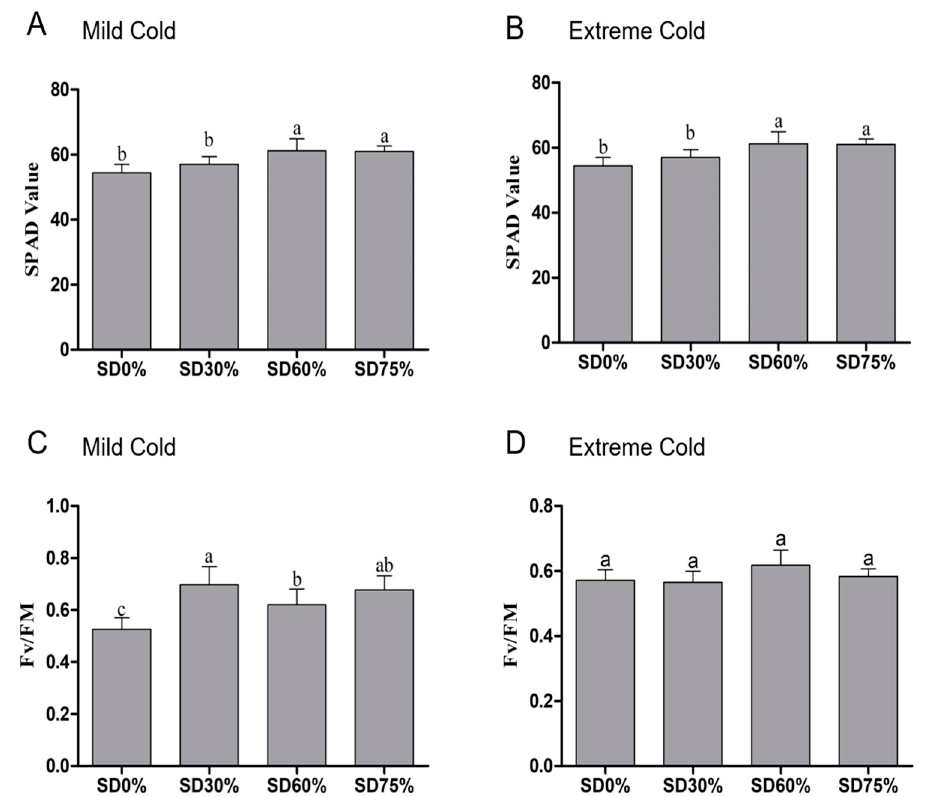
Figure 4. Effects of shading nets on soil plant development analysis values recorded during ( A ) mild cold and ( B ) extreme cold conditions. Photochemical efficiency was recorded during ( C ) mild cold and ( D ) extreme cold conditions. Different letters on the top of the columns within each figure represent significant differences between the treatments indicated by LSD test at p <